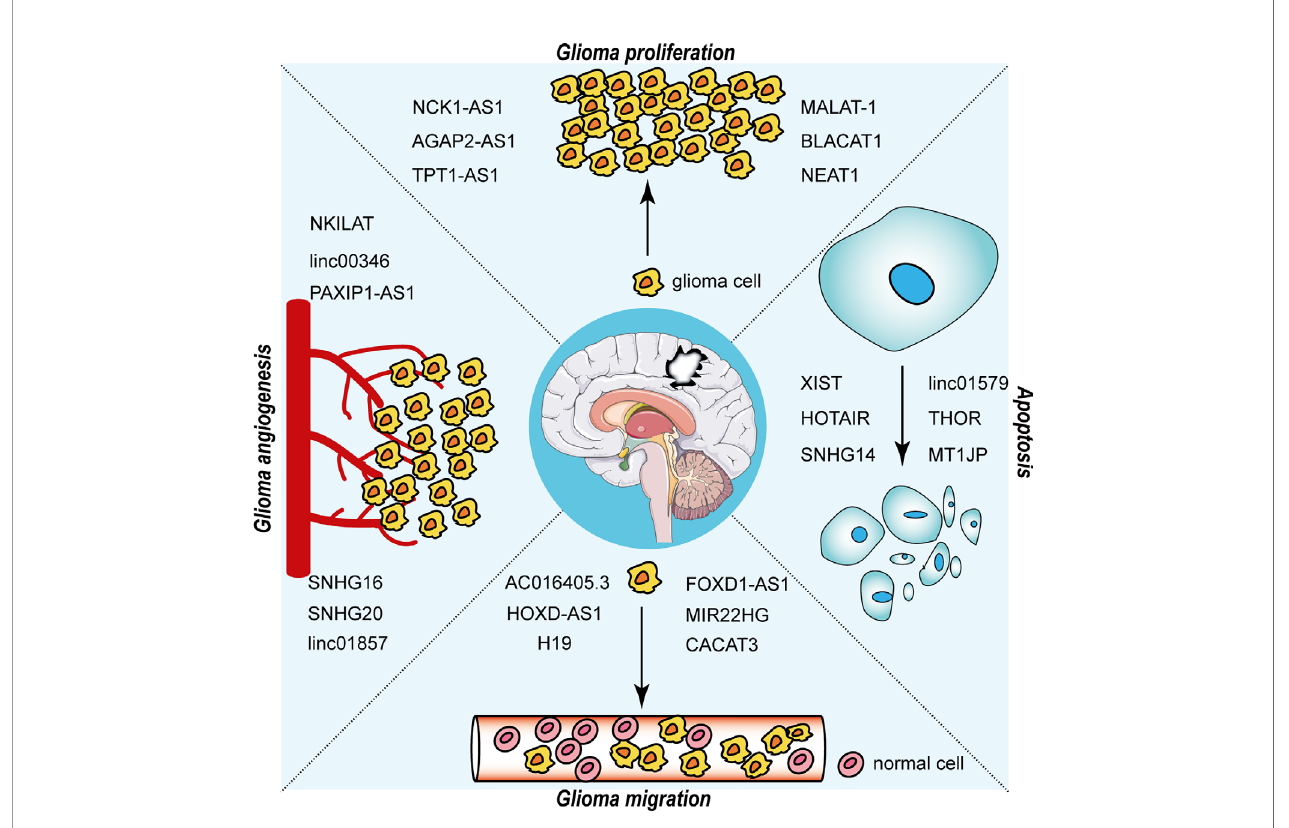
FIGURE 2 | LncRNAs in the proliferation, migration, apoptosis and angiogenesis of